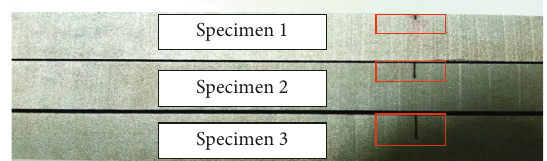
Figure 11: Picture of testing beam specimen. Table 4: Comparisons of the first two natural frequencies from the proposed method with 8 × 8 stiffness matrix, the FEFM with 4 × 4 stiffness matrix, and the experimental results for a cracked can- tilever beam with open